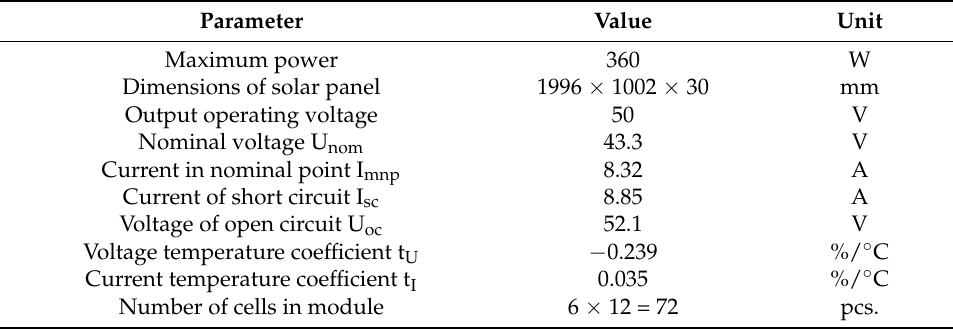
Table 1. Parameters of the HVL-360/HJT module.